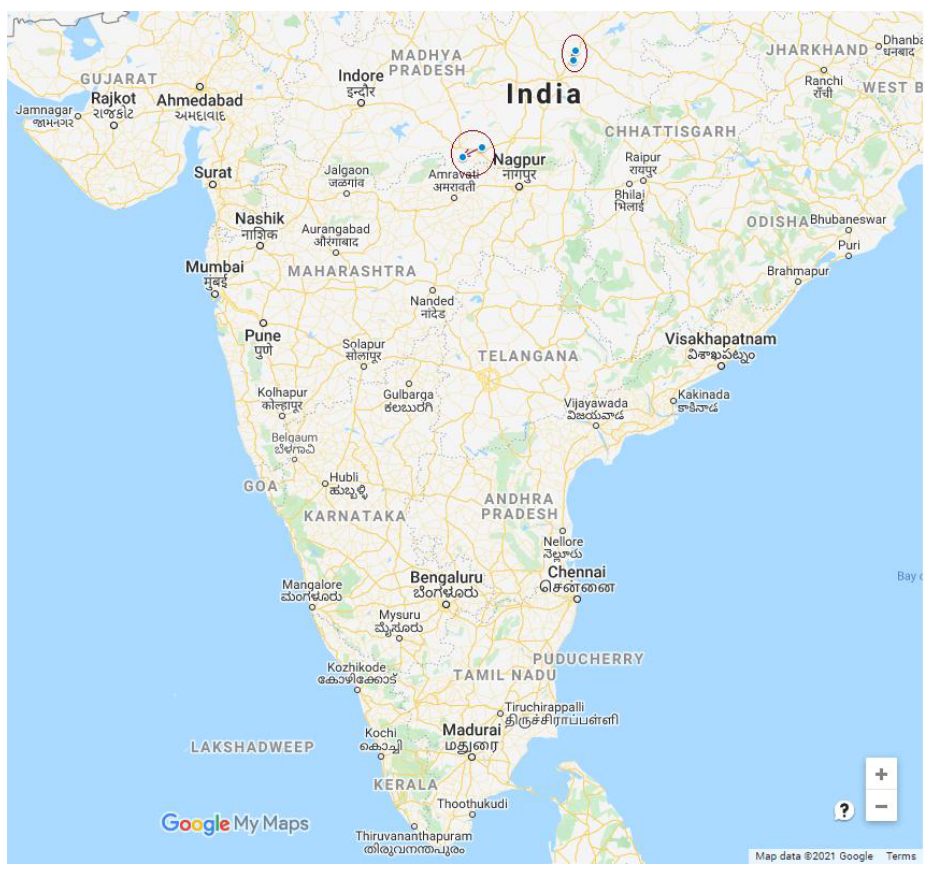
Figure 2 Movements of Population and Economic Centres in India